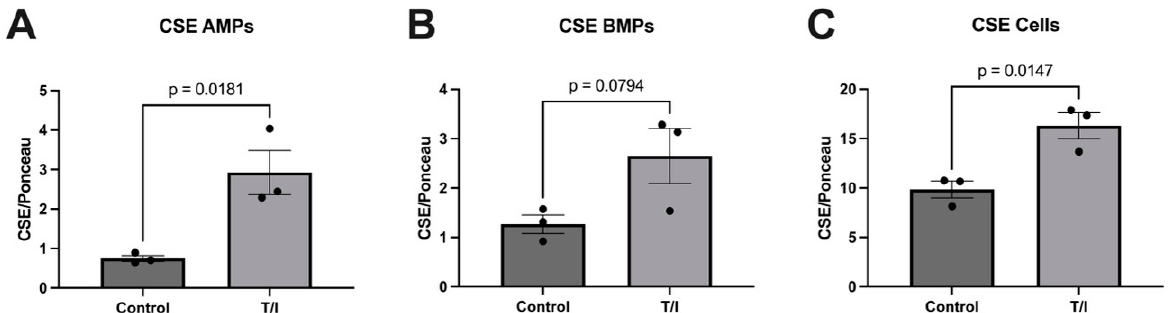
Figure 1. Analysis of CSE in apical microparticles (AMPs), basolateral microparticles (BMPs), and hCMEC/D3 human brain microvascular endothelial cells. Data are normalized to Ponceau staining.